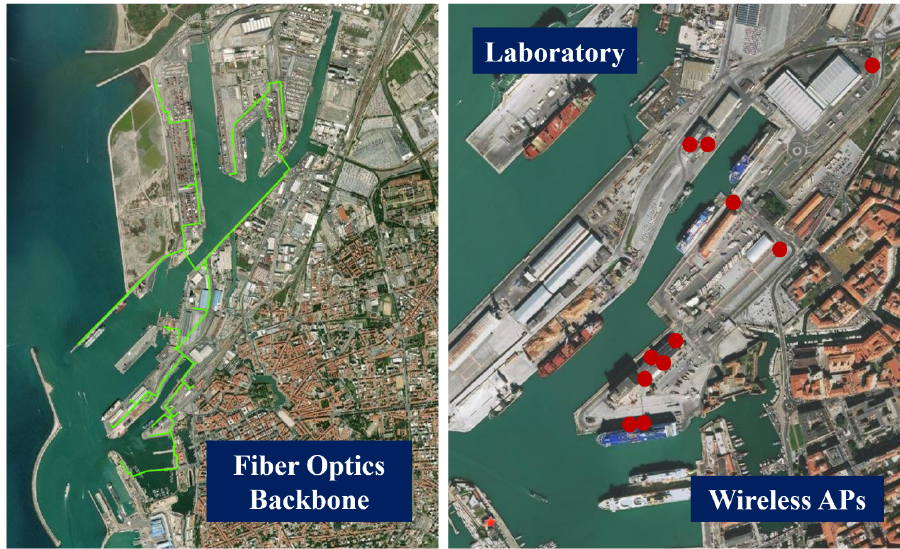
Figure 3. Cabled and wireless network layout of Livorno